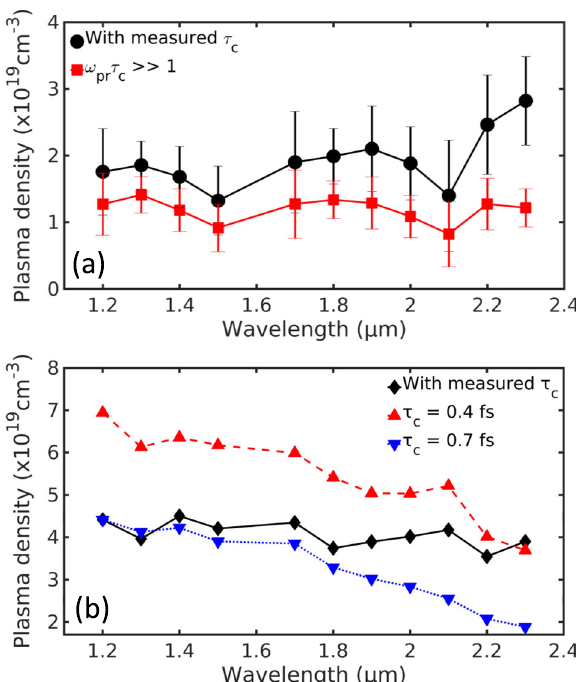
Fig. 3 Simulation results with the measured electron collision times. a Measured plasma density analysis with (black circle) and without (red square) the assumption of ω pr τ c (cid:3) 1, where ω pr is the probe angular frequency and τ c is the electron collision time. b Simulated plasma densities versus wavelength with constant τ c = 0.4 fs (red dashed line), 0.7 fs (blue dotted line), and with measured collision times (black solid line). Simulation results using the measured collision times agree well with the observed wavelength scaling of plasma density. The error bars correspond in a to the standard deviation of 35 laser shots.